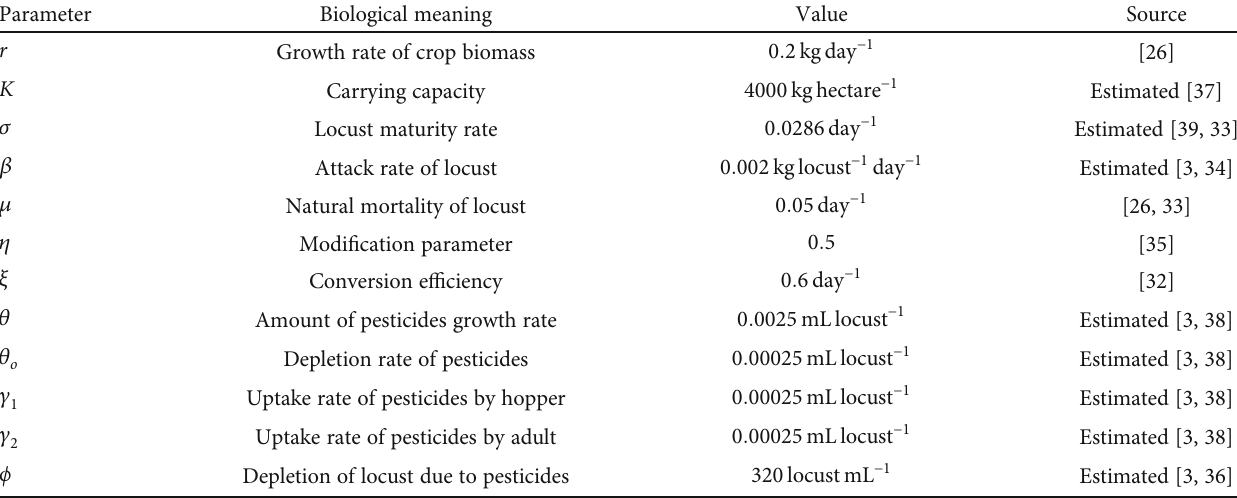
Table 1: Model parameter baseline values.